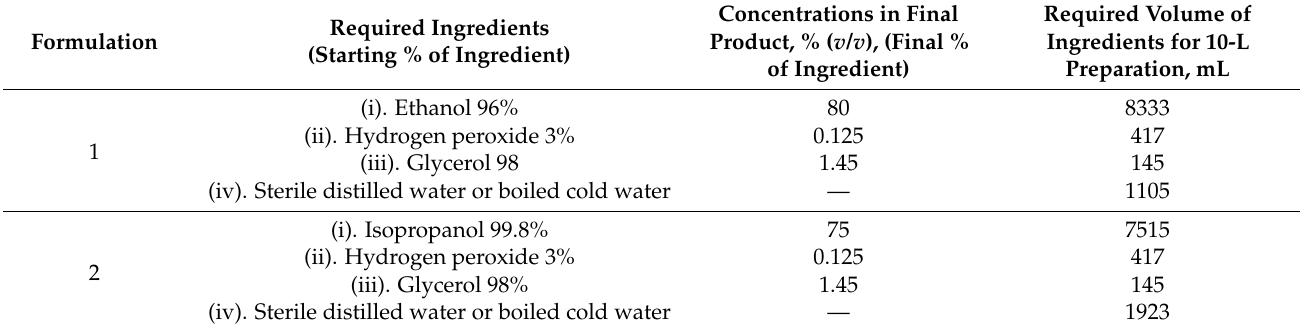
Table 3. World Health Organization recommended formulations for local production of alcohol-based hand sanitizer. Required Ingredients Formulation (Starting % of Ingredient)